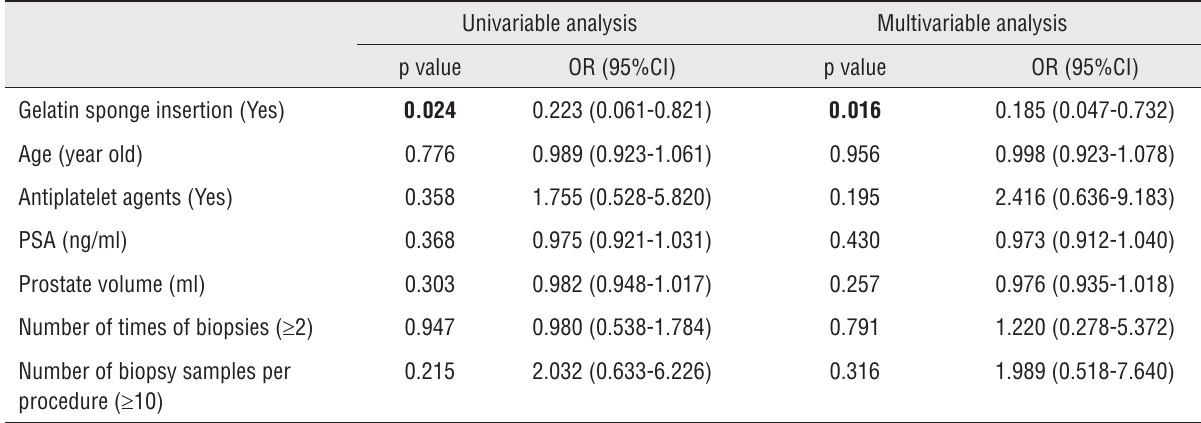
Table 3 - Logistic regression